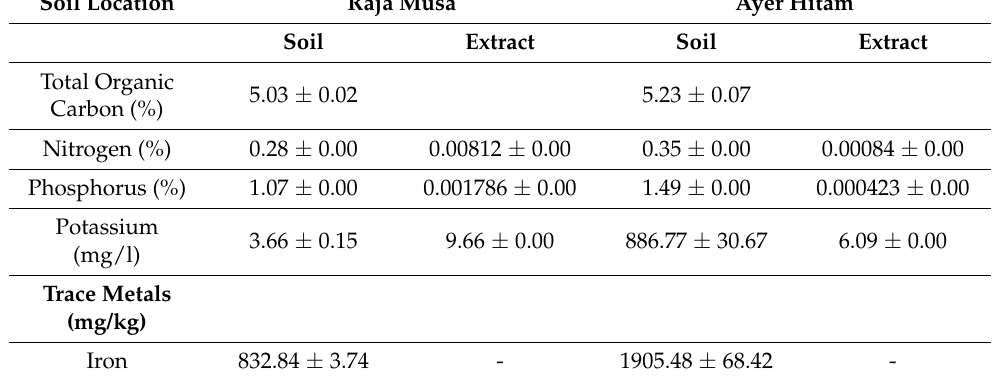
Table 2. The means value of chemicals properties for RM and AH soils samples. Soil Location Raja Musa Ayer Hitam Soil Extract Soil Extract Total